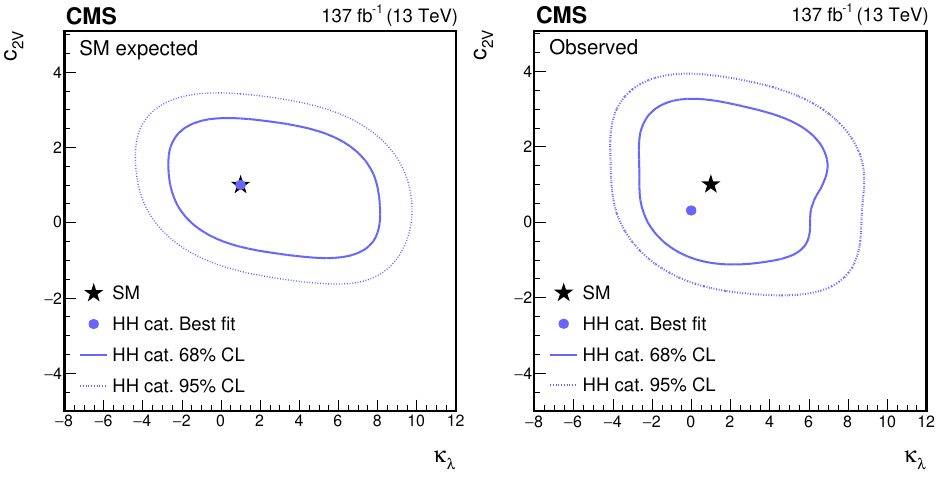
, c ) plane evaluated λ 2V = 0.0, c λ 2V = 1.0, c = 1.0) by a black λ 2V